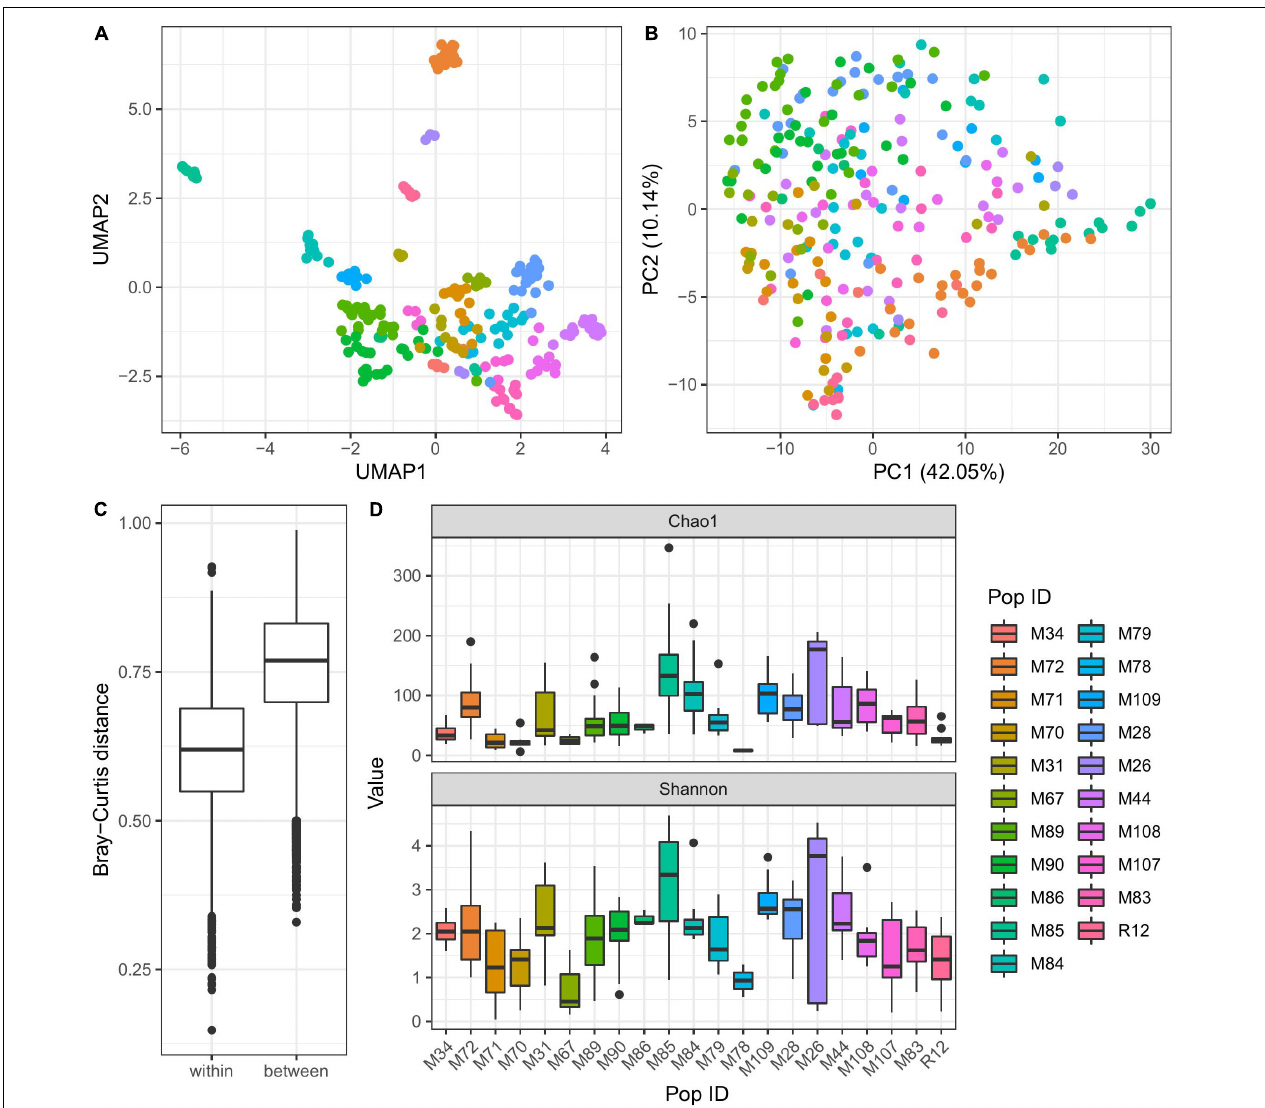
FIGURE 2 | Influence of population identity on bacterial colonization in Hydra . UMAP dimensionality reduction (A) and PC-analysis (B) of β -diversity (Bray–Curtis) shows separation of the samples by population, thus environmental conditions. The separation of microbial communities by population is supported by Adonis test ( R 2 = 0.41, p ≤ 0.001 with 999 permutations, Table 2 ). Bray–Curtis (C) dissimilarities within one population are generally smaller than those between populations. Furthermore, population ID is a major determinant for alpha diversity (D) (linear model on Shannon index, p ≤ 0.001, Table 3